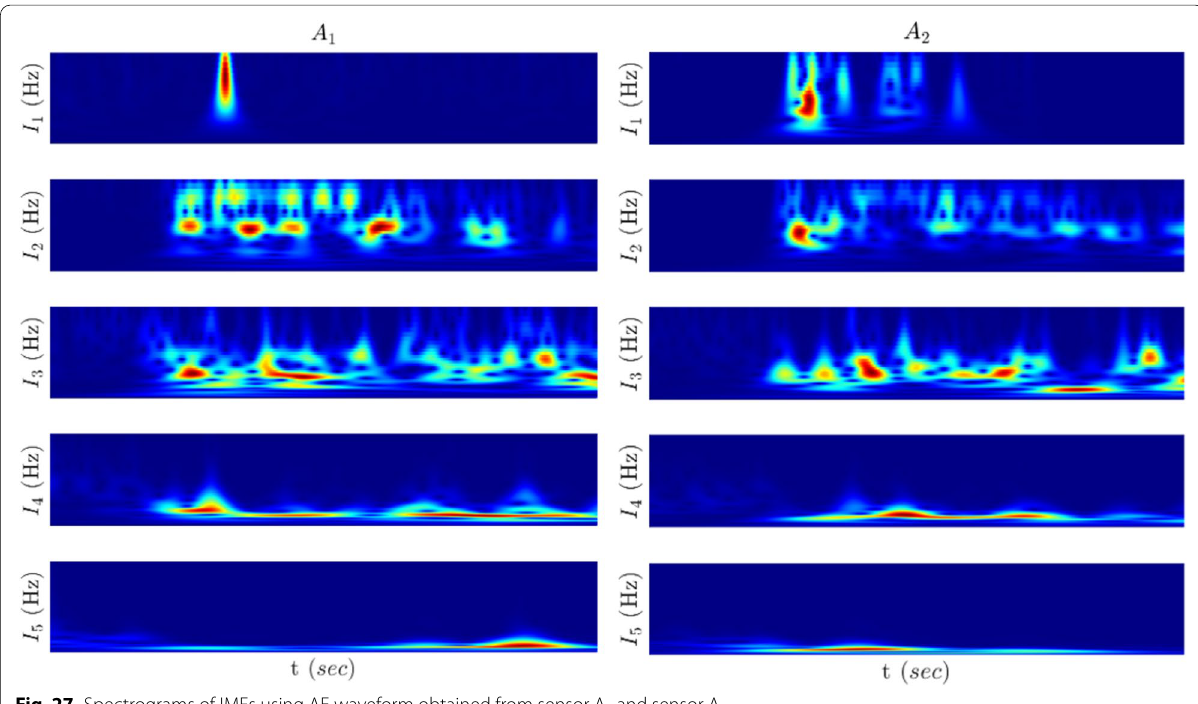
Fig. 27 Spectrograms of IMFs using AE waveform obtained from sensor A 1 and sensor A